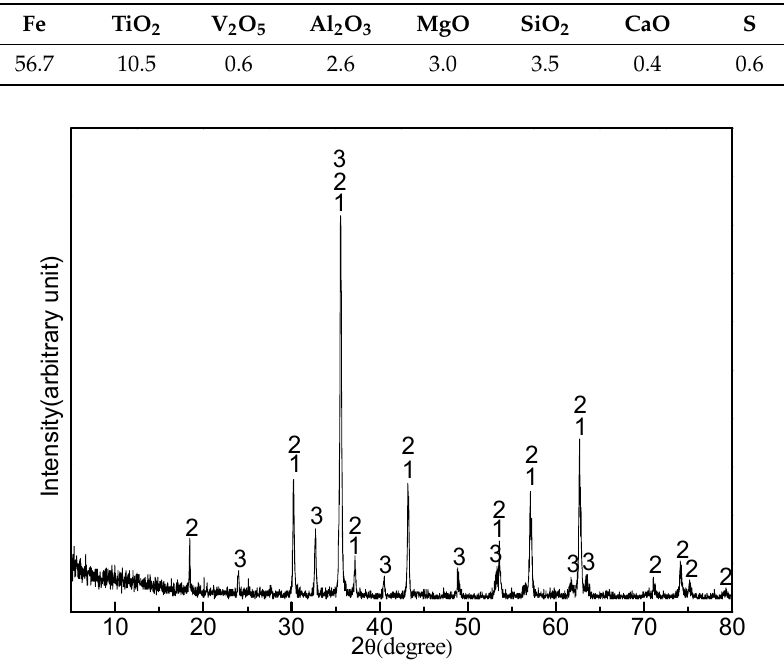
Figure 2. XRD patterns of TMCs . 1—Fe 2.75 Ti 0.25 O 4 (PDF#75 ‐ 1374); 2—Fe 3 O 4 (PDF#19 ‐ 0629); 3— FeTiO 3 (PDF#29 ‐ 0733).